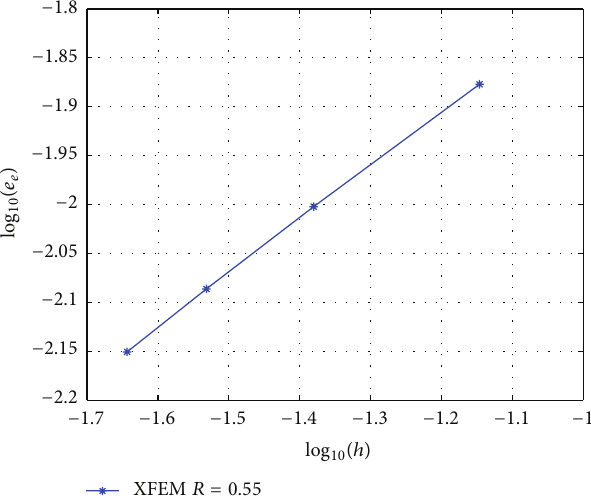
Figure 11: The convergence in the energy norm of XFEM versus ℎ (mesh size) for the sheet with an edge crack under